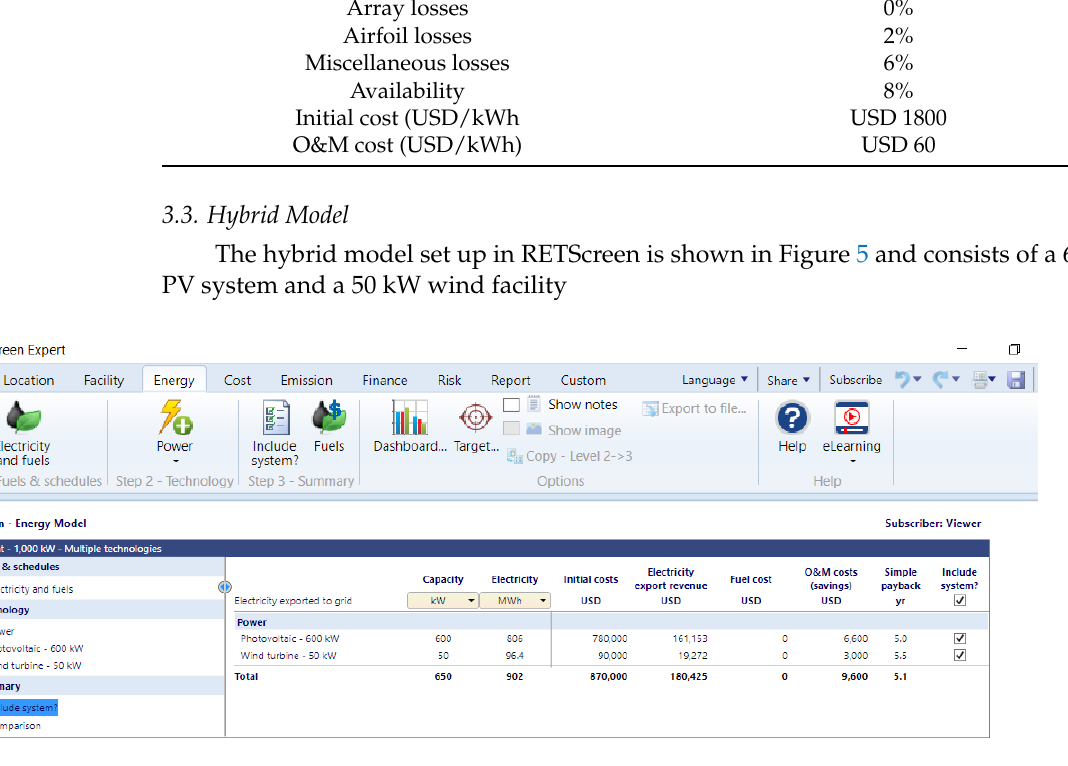
Figure 5. Solar–Wind HRES in RETScreen.